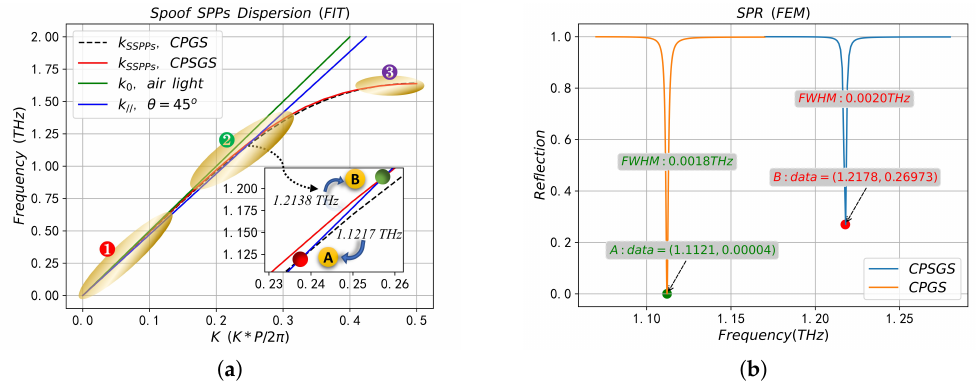
Figure 2. Dispersion curve ( a ) and reflection spectrum ( b ) of SSPPs on CPGS and